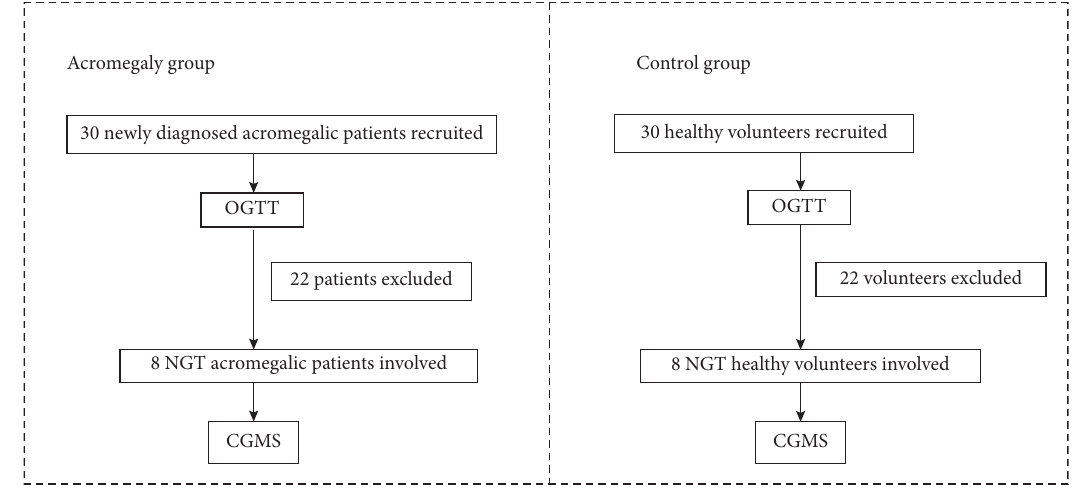
Figure 1: Research